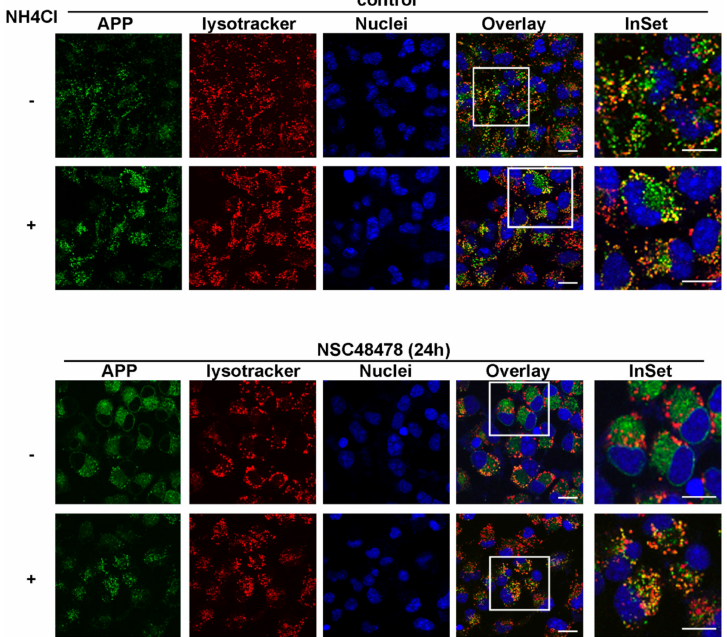
Figure 8. NH 4 Cl rescues APP localization in endolysosomal compartment. The cells were treated as above, with the exception that LysoTracker was added in vivo before fixation and immunofluorescence analysis. Plus ( + ) and minus (-) indicate the presence or absence of NH 4 Cl. Scale bars, 10 µ